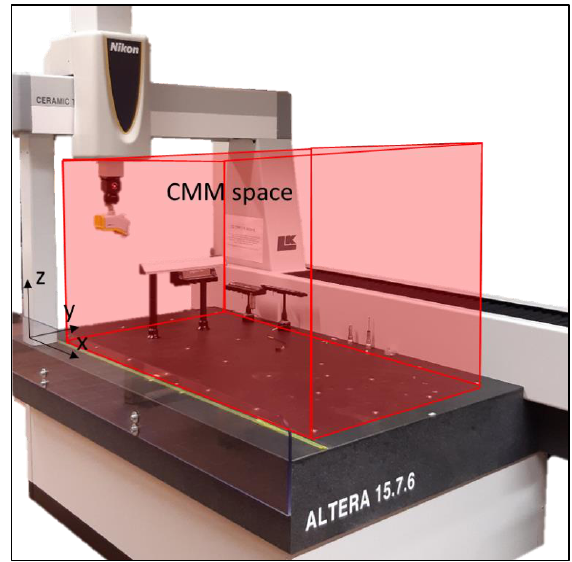
Metrology 2022 , 2, FOR PEER REVIEW Figure 1. The CMM with the CMM space. Figure 1. The CMM with the CMM space.